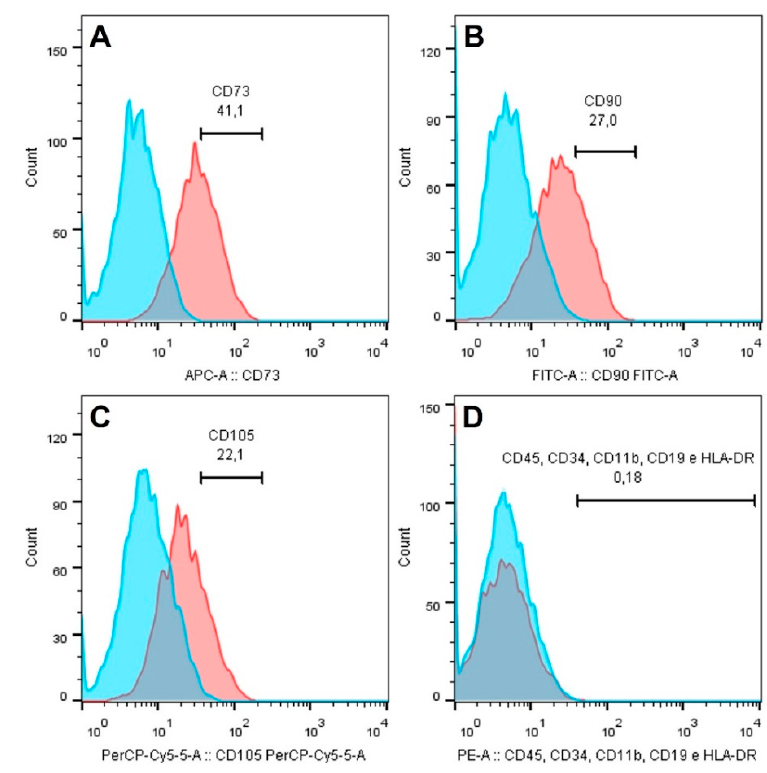
Figure 1. Expression of stem cell markers CD90 ( A ), CD73 ( B ), CD105 ( C ), and negative cocktail ( D ) in fibroblasts of periodontal ligament.